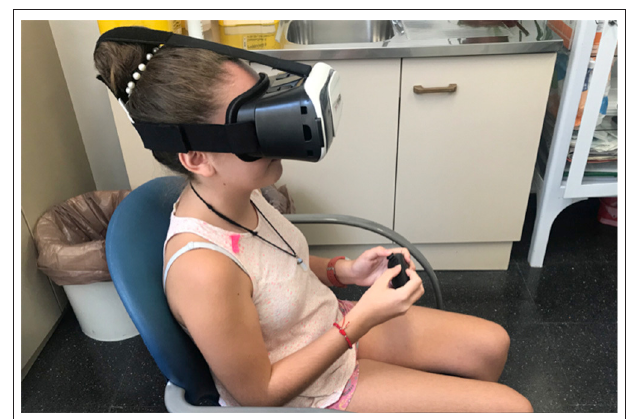
FIGURE 1 | SVV measurement with a device based on virtual